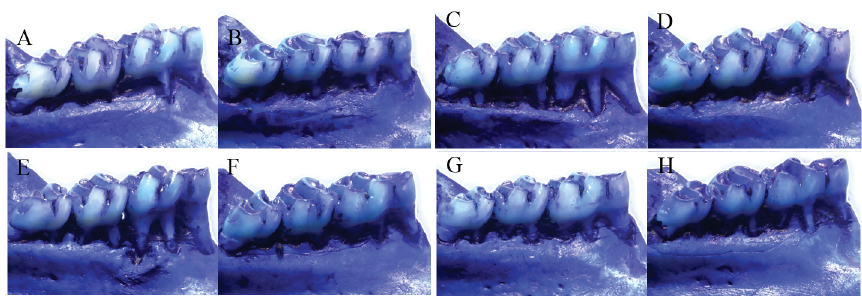
Table 3. Alveolar bone loss (mm — mean ± standard deviation) in animals treated with β -glucans from Saccharomyces cerevisiae (30mg/kg/day) during 28 days. PERIODONTAL DIABETES